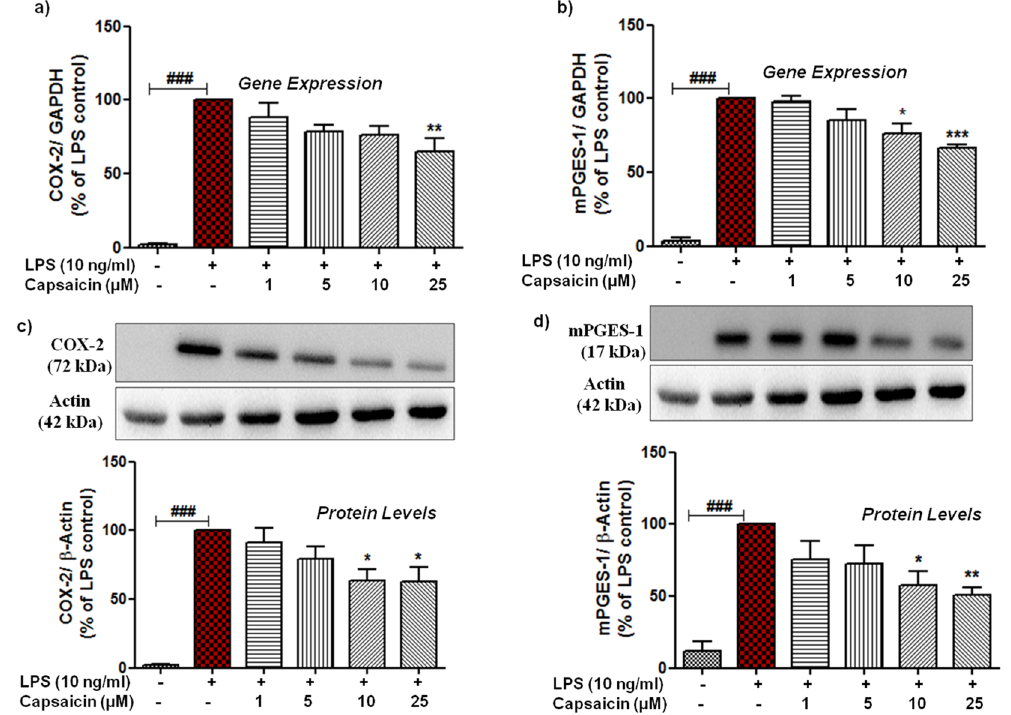
Figure 6. Effects of capsaicin (cap) on gene expression of COX-2 and mPGES-1 in LPS-activated microglia. Effects of cap on protein level of COX-2 and mPGES-1. Cells were pre-treated with cap (1–25 µ M) for 30 min followed by incubation of cells with or without LPS (10 ng/ml) for the next 4 h. Gene expression of COX-2 and mPGES-1 was studied. Afterwards, gene expression of ( a ) COX-2 and ( b ) mPGES-1, was analysed by real- time quantitative PCR. GAPDH was used as an internal control for normalisation and data were quantified by using comparative cycle threshold Ct method. Similarly, cells were treated with cap (1–25 µ M) for 30 min thereafter incubated with or without LPS (10 ng/ml) for 24 h. Whole cell lysates were subjected to western blot for COX-2, mPGES-1 and Actin. After the successful transfer of protein, membrane was blocked and eventually cropped horizontally into three pieces according to the target protein. First between 55 and 100 kda (for COX- 2, 72 kda), second between 35 and 55 kda (for Actin, 42 kda) and third between 10 and 25 kda (for mPGES-1, 17 kda). Representative blots for COX-2, mPGES-1 and Actin are shown (c & d upper panel) and densitometry analyses were performed ( c and d , lower panel). Representative original blots are included in Supplementary Information (Fig. S10). To confirm equal sample loading, β -actin were used for normalisation. Moreover, data are presented as percentage control of LPS. Statistical analyses were carried out by using one way ANOVA with post hoc student Newman-Keuls test (multiple comparisons). Results are expressed as means ± SE of 3–5 independent experiments. * p < 0.05; ** p < 0.01; *** p < 0.001 compared with LPS (10 ng/ml) activated cells. # p < 0.05; ## p < 0.01; ### p < 0.001 compared with control